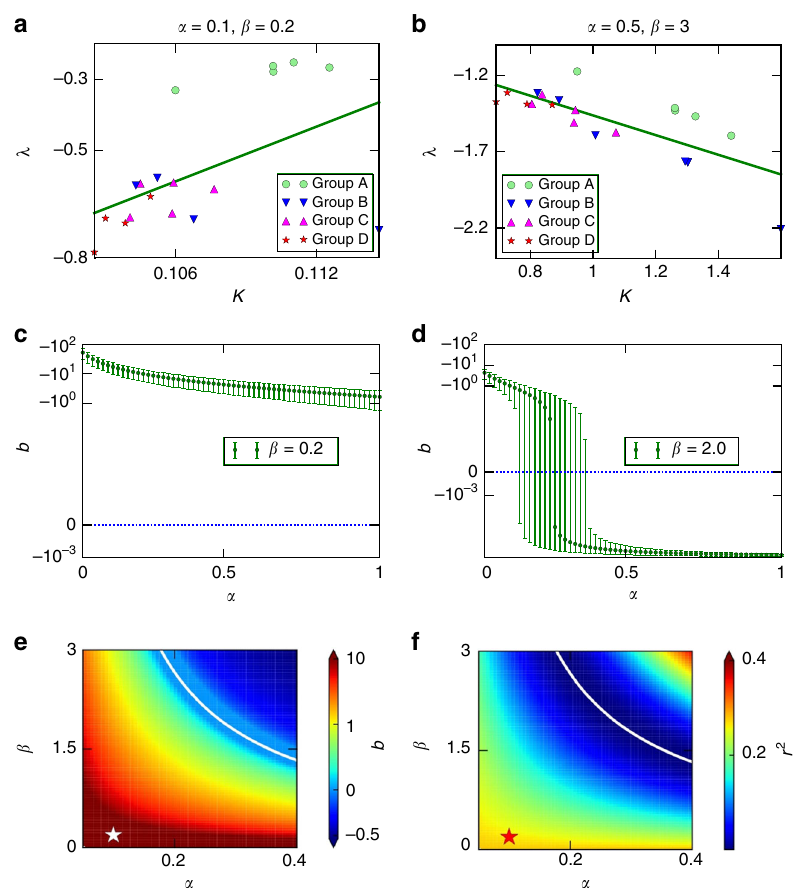
Fig. 3 Growth factor λ versus coupling parameter K. Positive ( a ) and negative ( b ) slopes in the regression lines indicate faster or slower dynamics for either rural or urban areas. c , d Variation of the slope b of the regression lines as a function of β for two different values of β , error bars are calculated directly from a linear regression of the data in ( a , b ). e Color-coded values of b across the α vs. β phase diagram. f Regression coef fi cients across the α - β space diagram. Star marks the location of Galicia (with α = 0.1, β =